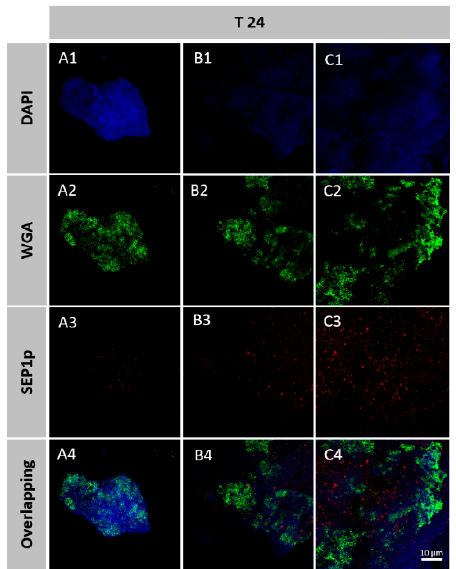
Figure 5. Confocal laser scanning microscopy (CLSM) images of S. epidermidis 9142 biofilm after phage treatment ( A – C ). The blue fluorescence corresponds to S. epidermidis cells, the green fluorescence corresponds to the matrix and red fluorescence shows the phage staining using the phage probes SEP1p. The bottom image present the overlap of the three channels discriminating the infected cells, non-infected cells and the matrix.